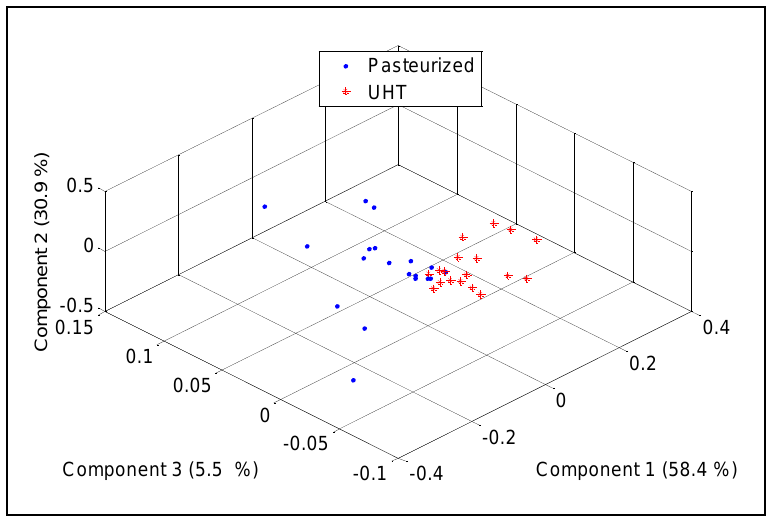
Figure 16. PCA plot for 14 sensors data.